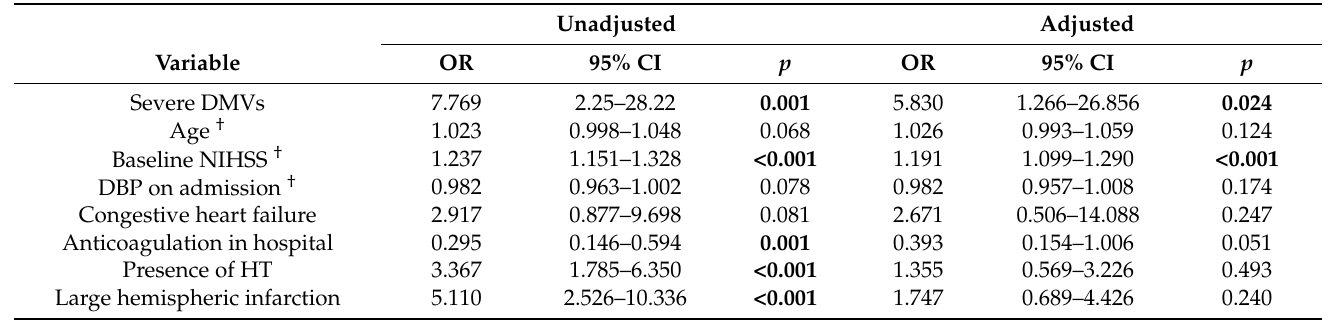
Table 3. Binary logistic regression analysis for associations between severe DMVs with poor functional outcomes at three months.